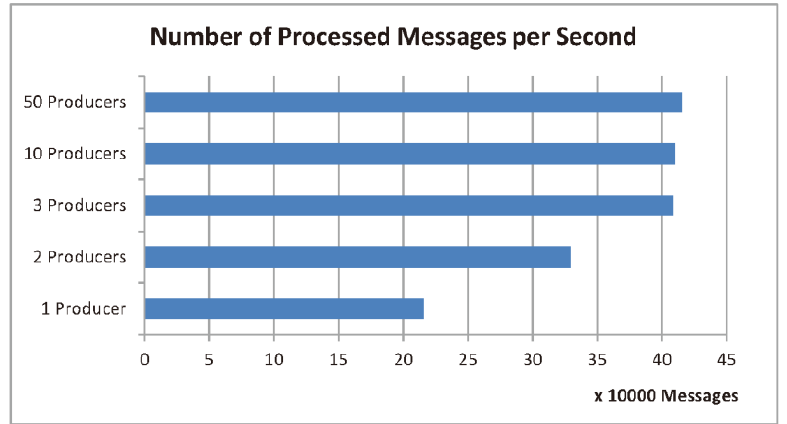
Figure 17. The number of processed messages per second for different number of kafka producers (clients) in the cloud